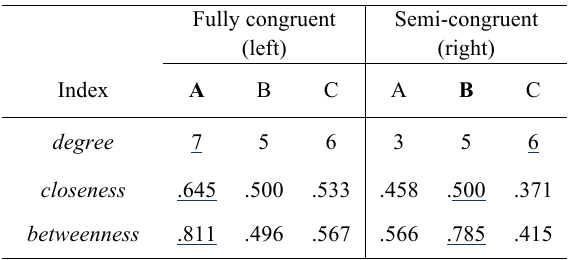
Figure 2. Core status of the pivotal nodes A and B . Centrality measures of the pivotal nodes